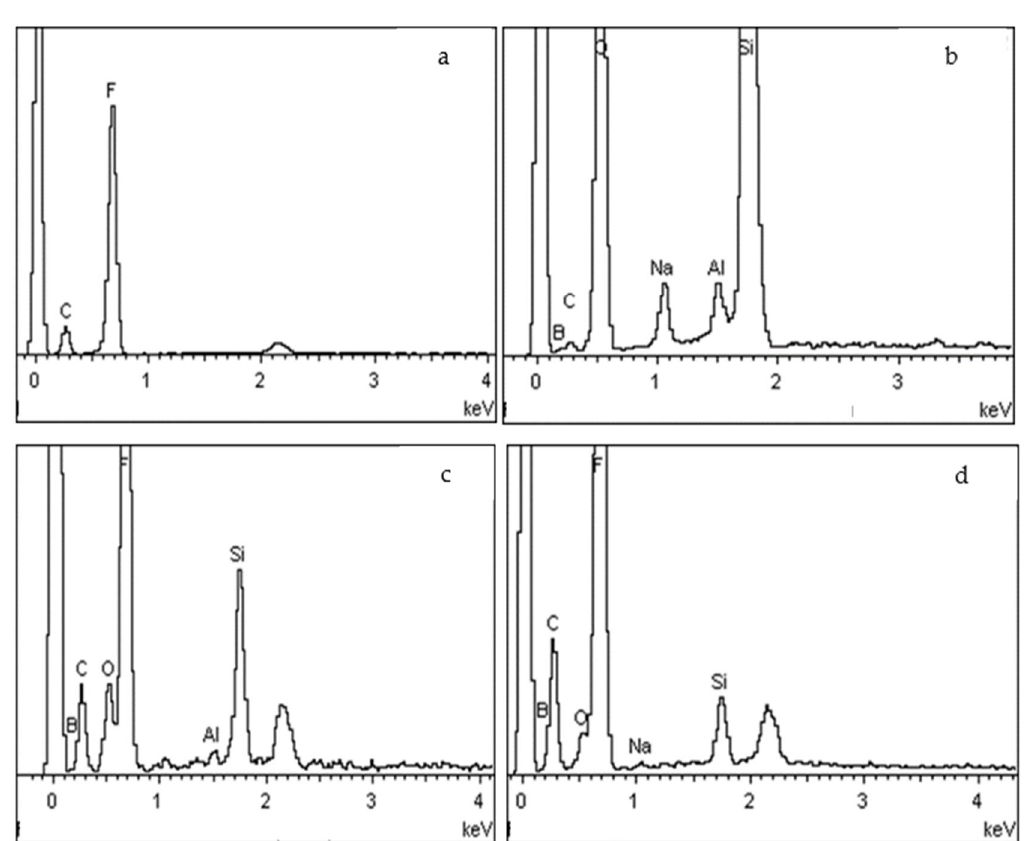
Figure 4. EDX spectra of ( a ) PTFE, ( b ) 63 recycled BRS powder, ( c ) PTFE/recycled BRS at 25 µm BRS and ( d ) PTFE/recycled BRS at 106 µm BRS.